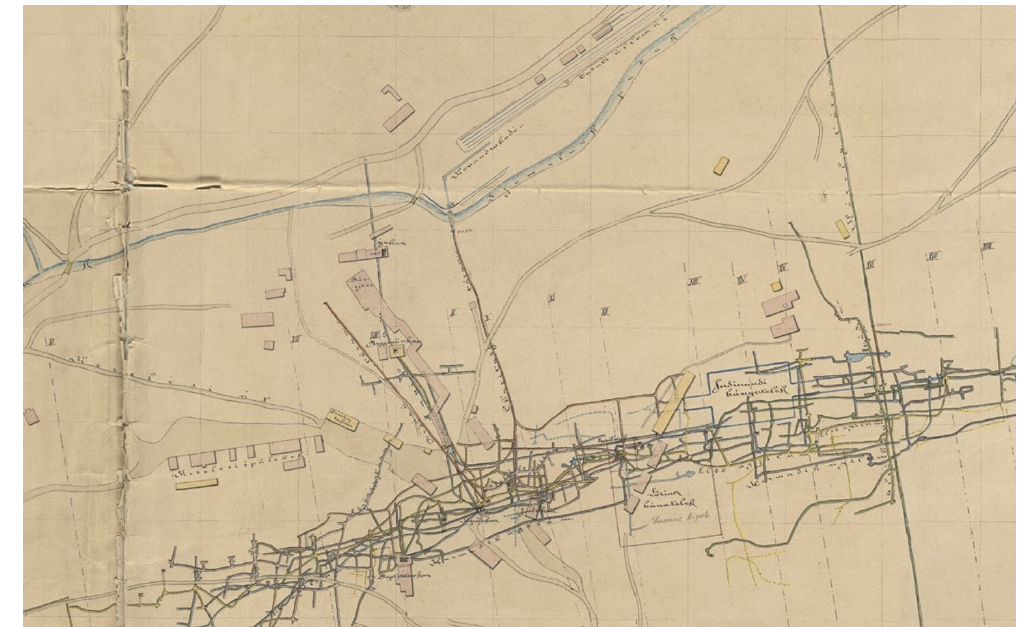
Figure 8. Visualisation of mining underground in Smolník in historical map (source: Slovak Mining Archive, Banská Štiavnica; the copy of the map was obtained in